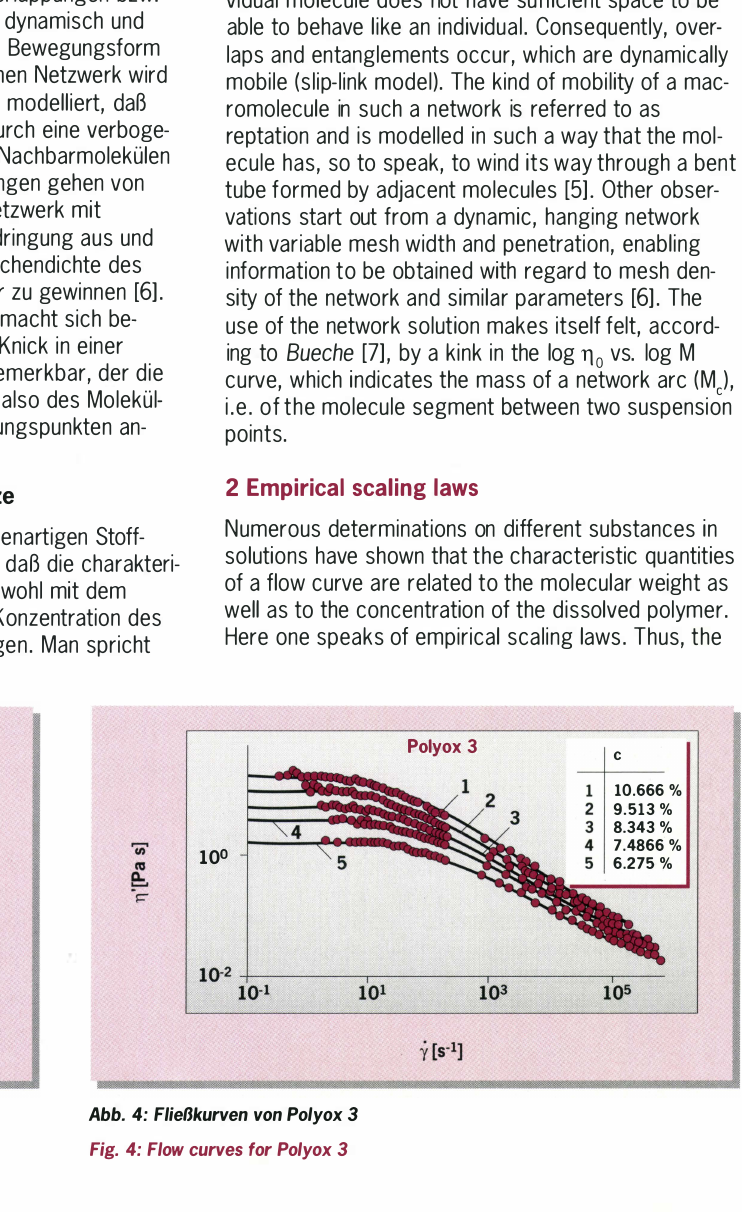
Fig. 4: Flow curves for Polyox